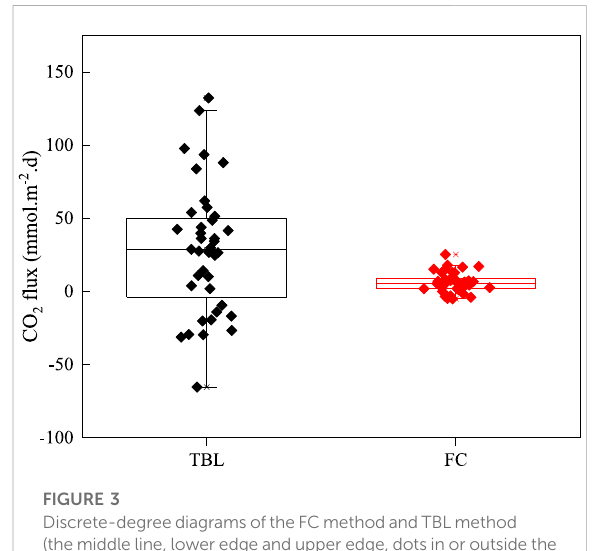
FIGURE 3 Discrete-degreediagramsoftheFCmethodandTBLmethod (the middle line, lower edgeand upper edge, dots in oroutside the boxes refer to mean values, 25th and 75th, 5th and 95th, and < 5th and > 95th percentiles of all data, respectively).